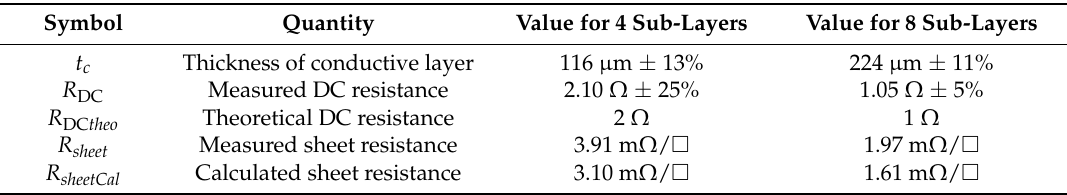
Table 1. Thickness and resistance characteristics of printed